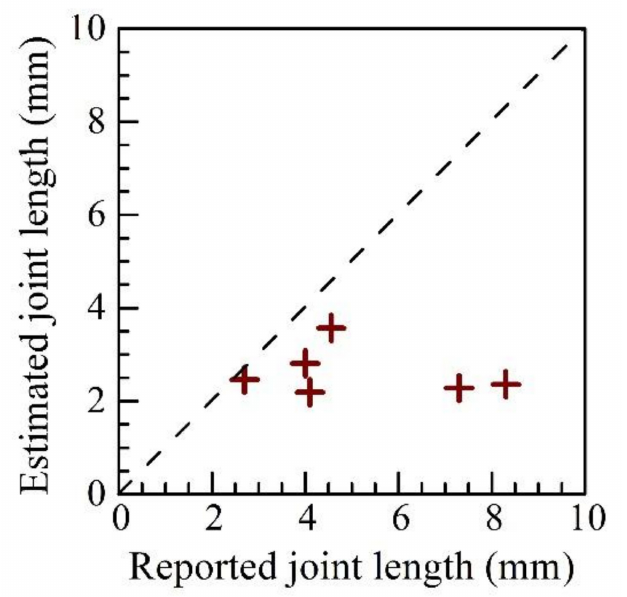
Figure 5. Analytically calculated and the corresponding experimentally measured (from the literature, as shown against each point) values of the joint length (W L ) for MPW of tubes and sheets. Details of the process conditions and coil geometry details are provided in Table 8. Experimentally measured data are taken from references